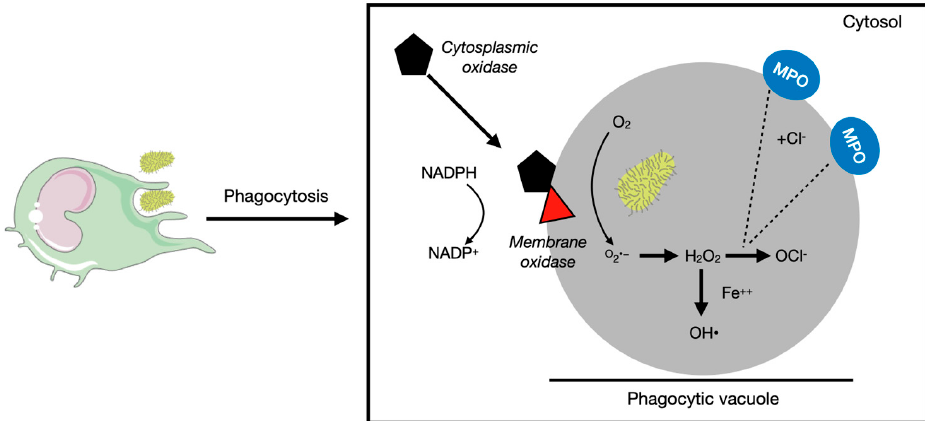
Figure 2. O 2 reduction generates O 2 •− , which by spontaneous dismutation leads to H 2 O 2 . In phagolysosomes, H 2 O 2 is converted enzymatically by the MPO enzyme (upon fusion of azurophil granules carrying the enzyme with the phagolysosome) to OCl-, responsible for the bactericidal action. In the presence of ferric cation, H 2 O 2 may also be decomposed, generating HO • (Fenton reaction). Parts of the figure were drawn using pictures from Servier Medical Art (Creative Commons Attribution 3.0).